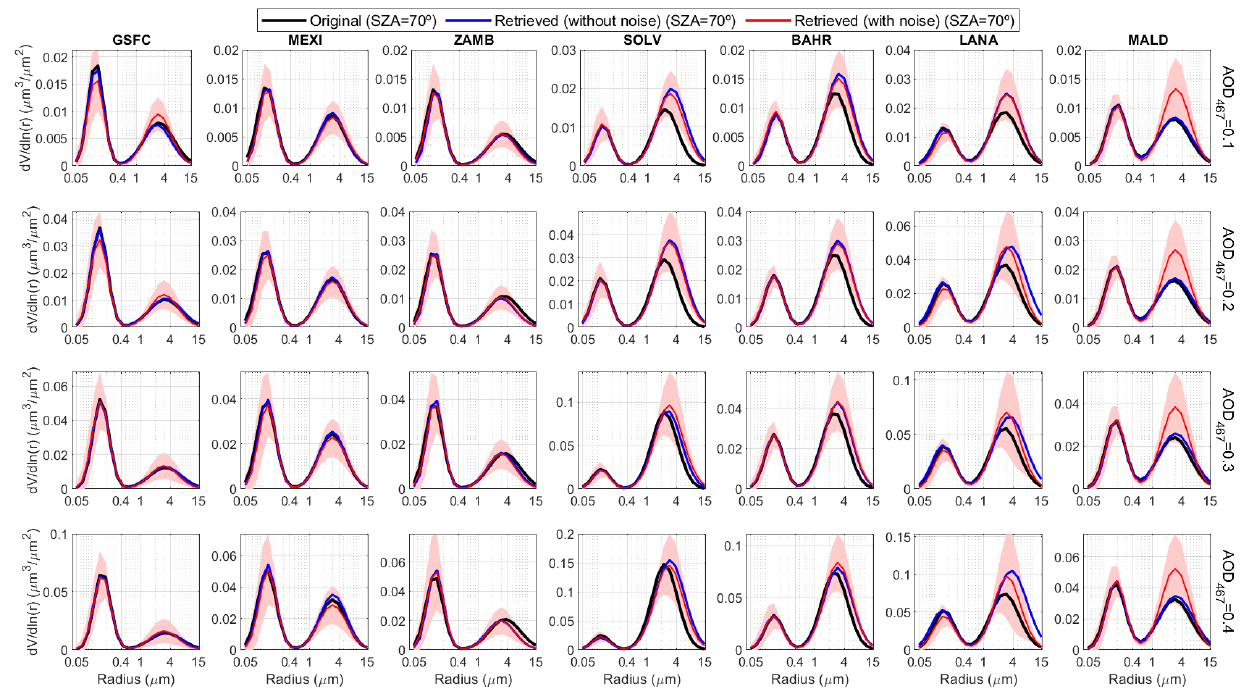
Figure 6. Original size distribution used as reference (black line), size distribution retrieved without noise (blue line), and the median of all retrieved size distributions with noise (red line) for a solar zenith angle (SZA) equal to 70 ◦ . These size distributions are represented for different aerosol types (one type per column) and for values of AOD (aerosol optical depth) at 467nm (AOD 467 ) of 0.1 (first row), 0.2 (second row), 0.3 (third row) and 0.4 (last row). Red shadowed area corresponds to ± the standard deviation of all averaged size distributions retrieved with noise-perturbed synthetic